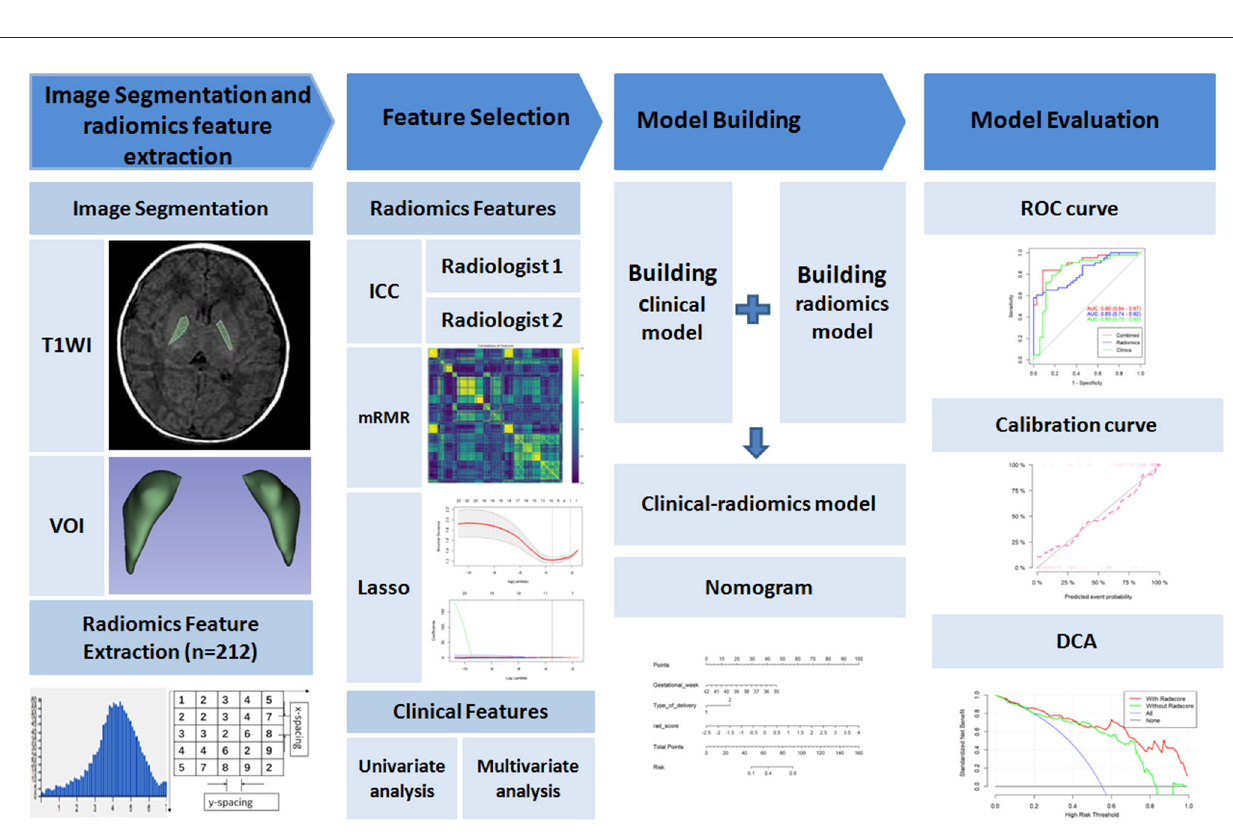
were blinded to clinical and group information. Features